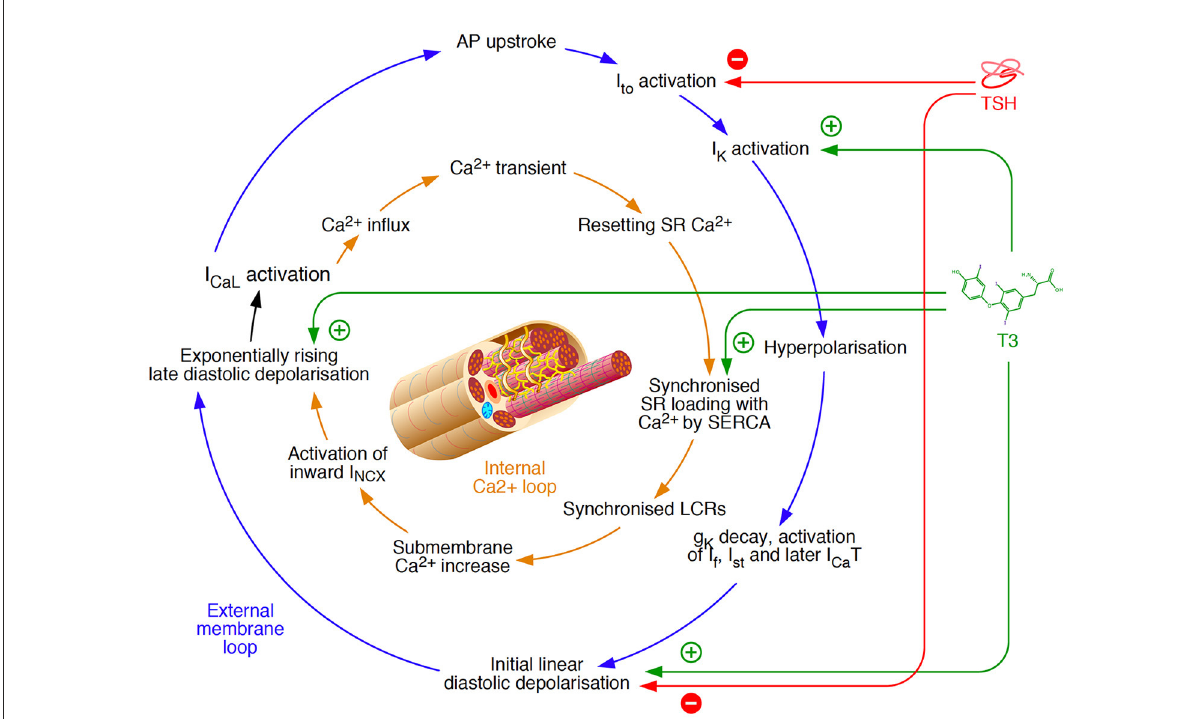
FIGURE2 Mechanisms of rhythm generation in cardiomyocytes based on a model by Maltsev et al. (85). Two loops, an external membrane loop and an internal calcium loop independently ensure the generation of impulses. Therefore, they provide some redundancy, but they are also intertwined at the stage of slow L-type Ca 2 + current (I CaL ) activation. Thyroid hormone signaling is able to modulate both loops simultaneously via interfaces at several sites (75, 81, 86–91), and direct myocardial effects of TSH are largely opposing (92). g K , ionic conductance for K + ; INCX, Na + /Ca 2 + exchange current; I CaT , T-type Ca2 + current; I f , hyperpolarisation-activated “funny” current; I K , voltage-gated K + current; I st , sustained non-selective current; I to , transient outward potassium current; LCR, local Ca 2 + release; SERCA, sarcoendoplasmic reticulum Ca 2 + -ATPase; SR, sarcoplasmic